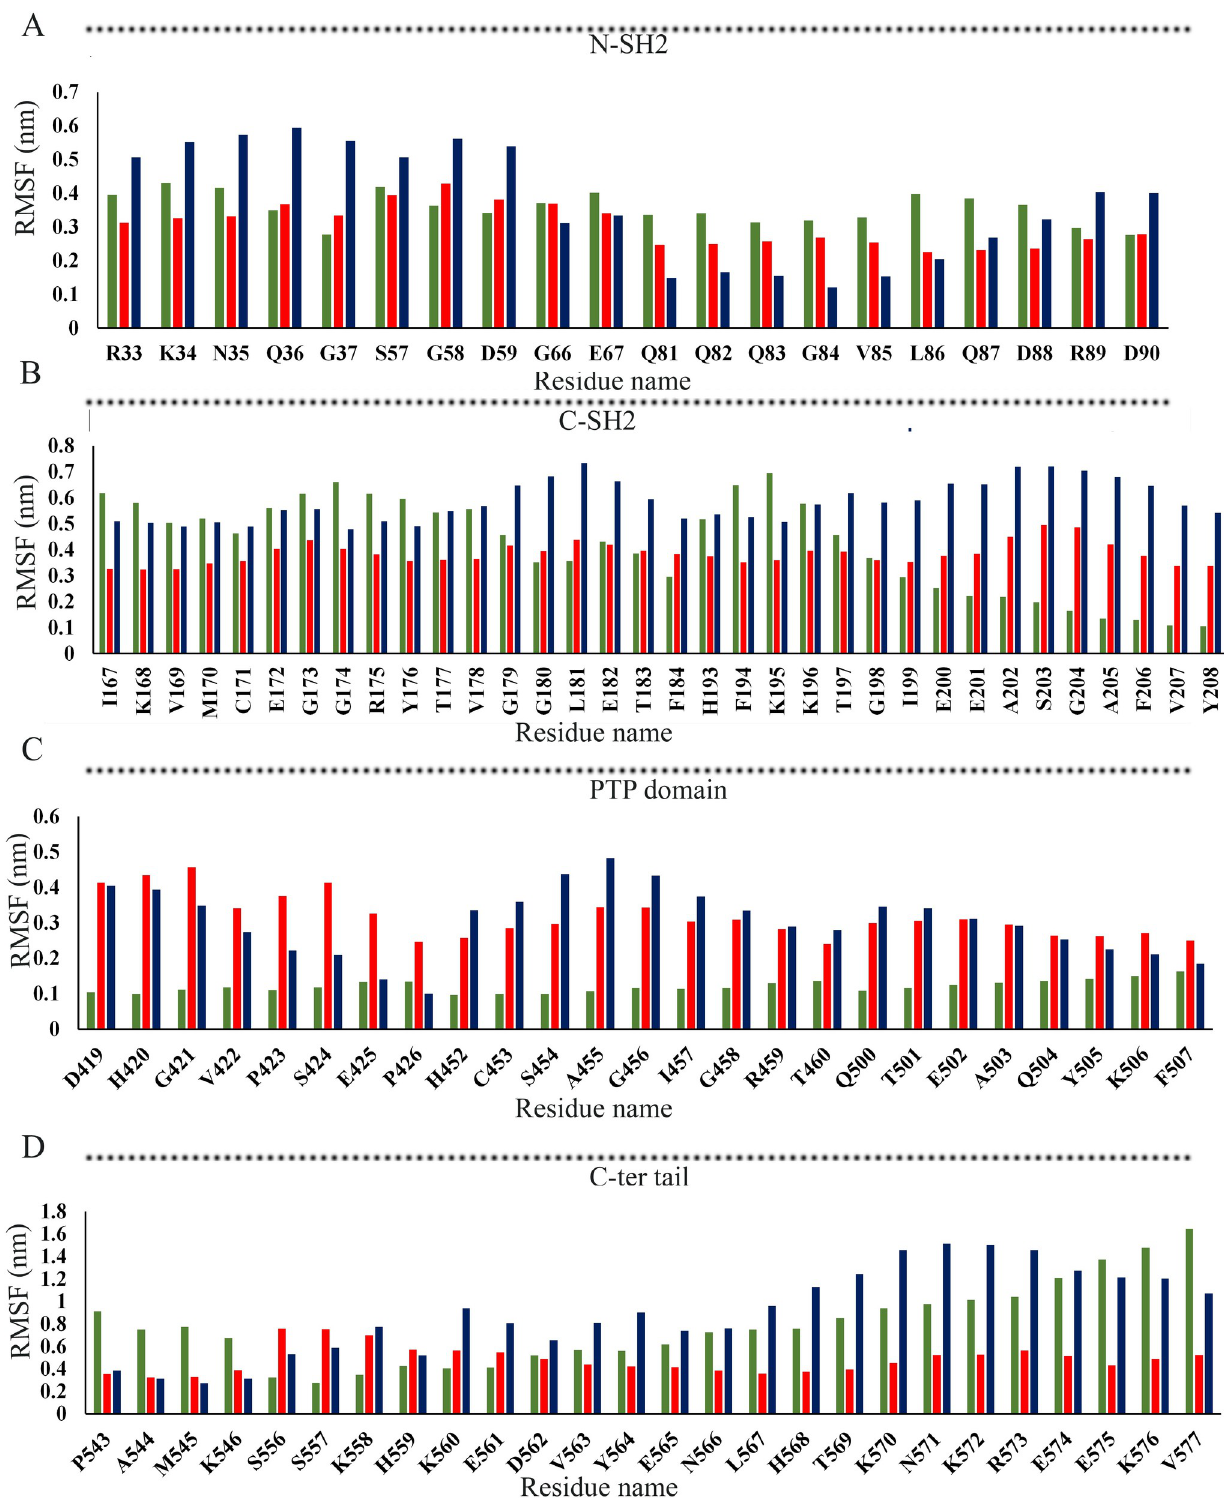
Fig 3. Comparative RMSF bar plots for SHP-1 domains. (A) N-SH2, (B) C-SH2, (C) PTP, and (D) C-terminal tail. Detailed color codes are given in the Fig 2 legend.